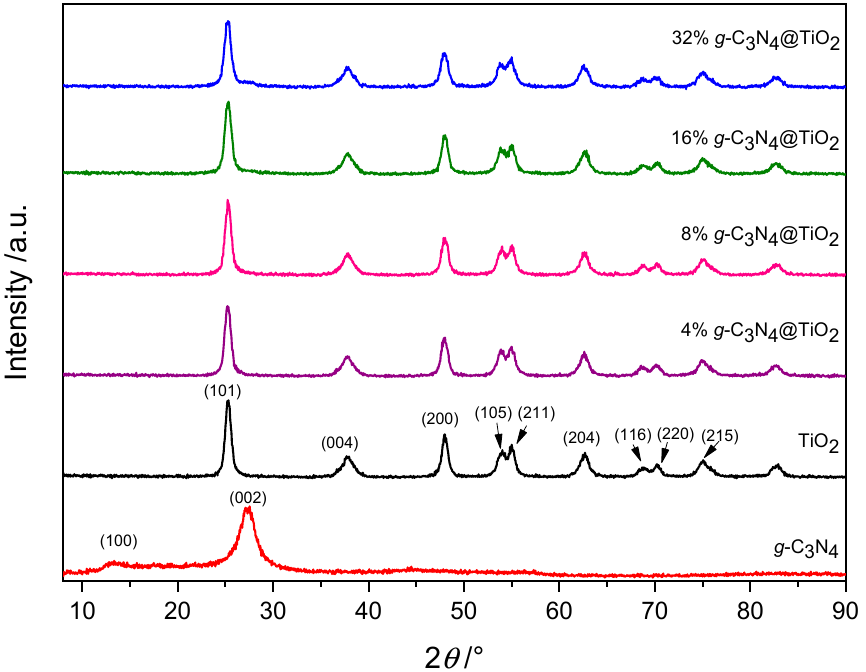
Figure 1. XRD patterns of prepared materials.